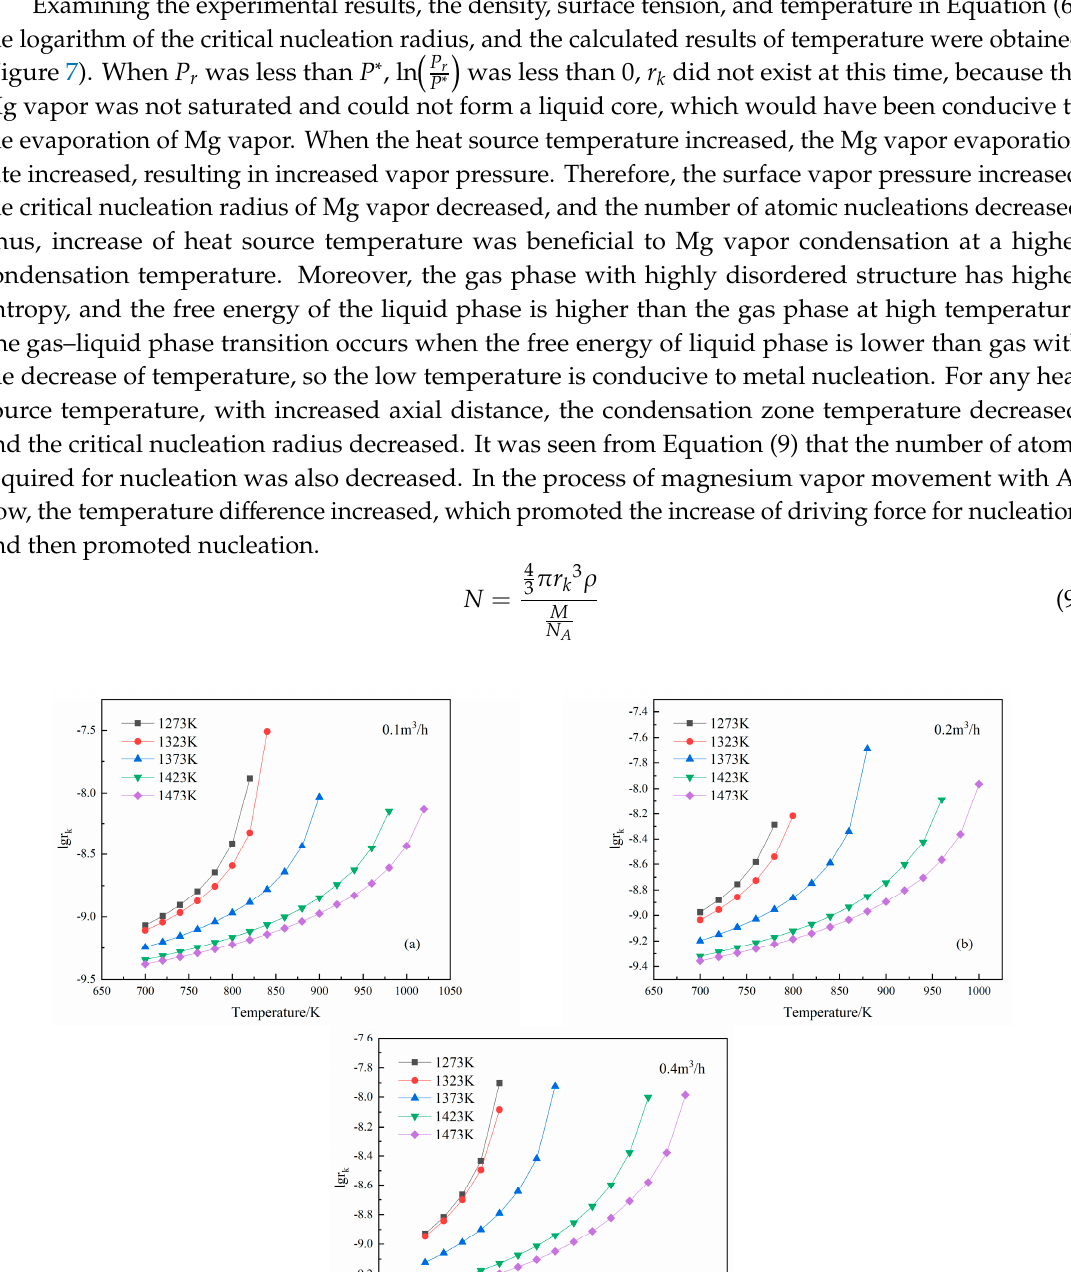
Table 2. Nucleation radius and number of atoms required for nucleation (1473 K heating, 0.2 m 3 /h Ar, 900–1000 K).